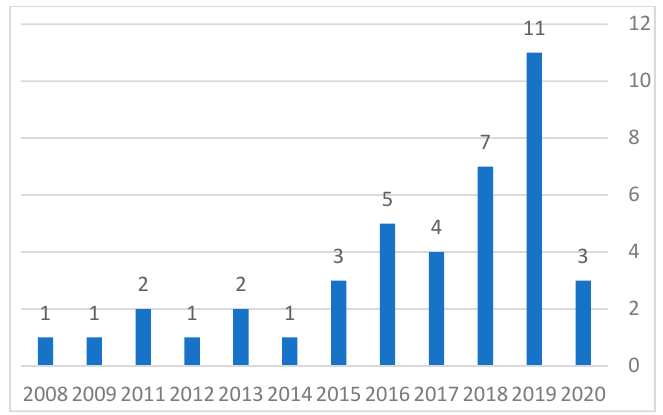
Figure 2. Number of papers per year.